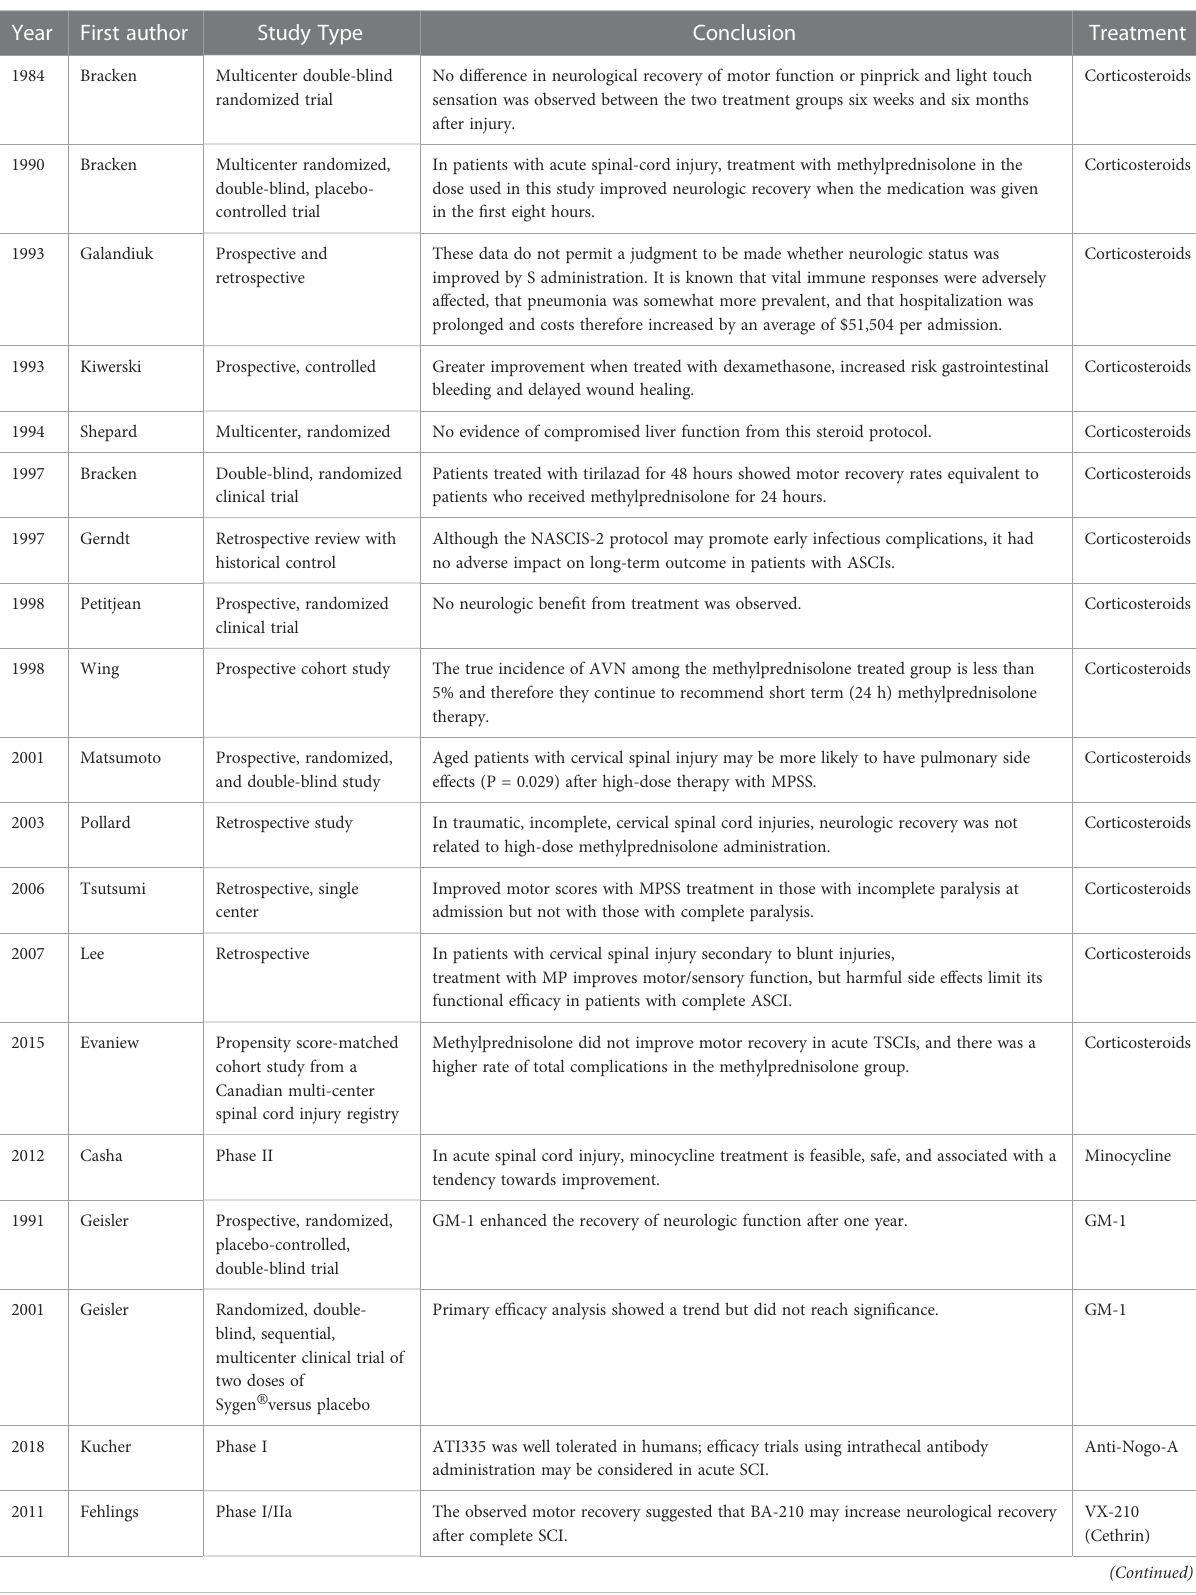
TABLE 1 Immunological pharmaceutical clinical studies summary